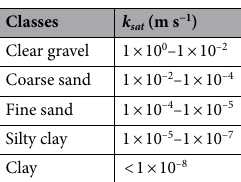
Table 2. Saturated hydraulic conductivity classes presented by Das and Sobhan 25